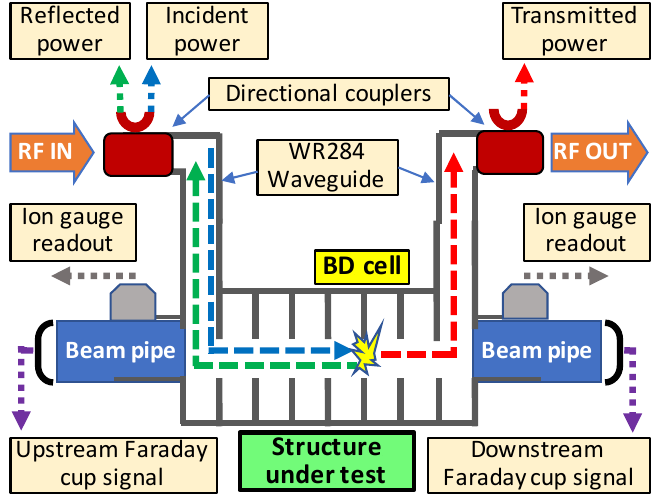
Figure 2. Layout of the DUT and diagnostic systems. The arrows show the signals read by the acquisition system.